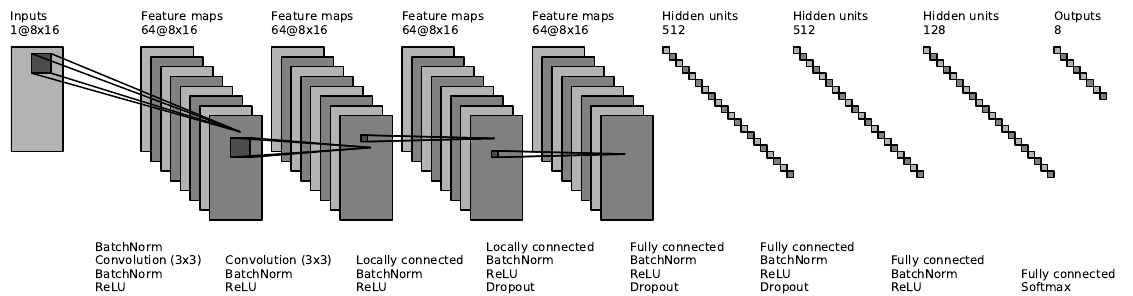
Figure 2. Outline of our ConvNet architecture. This is the ConvNet used for the recognition of 8 gestures from CapgMyo. The 8 × 16 input image is filtered by two convolution layers, followed by two locally connected layers and four fully connected layers. The boxes represent the inputs and outputs of different layers of the network. The text between the boxes describe the